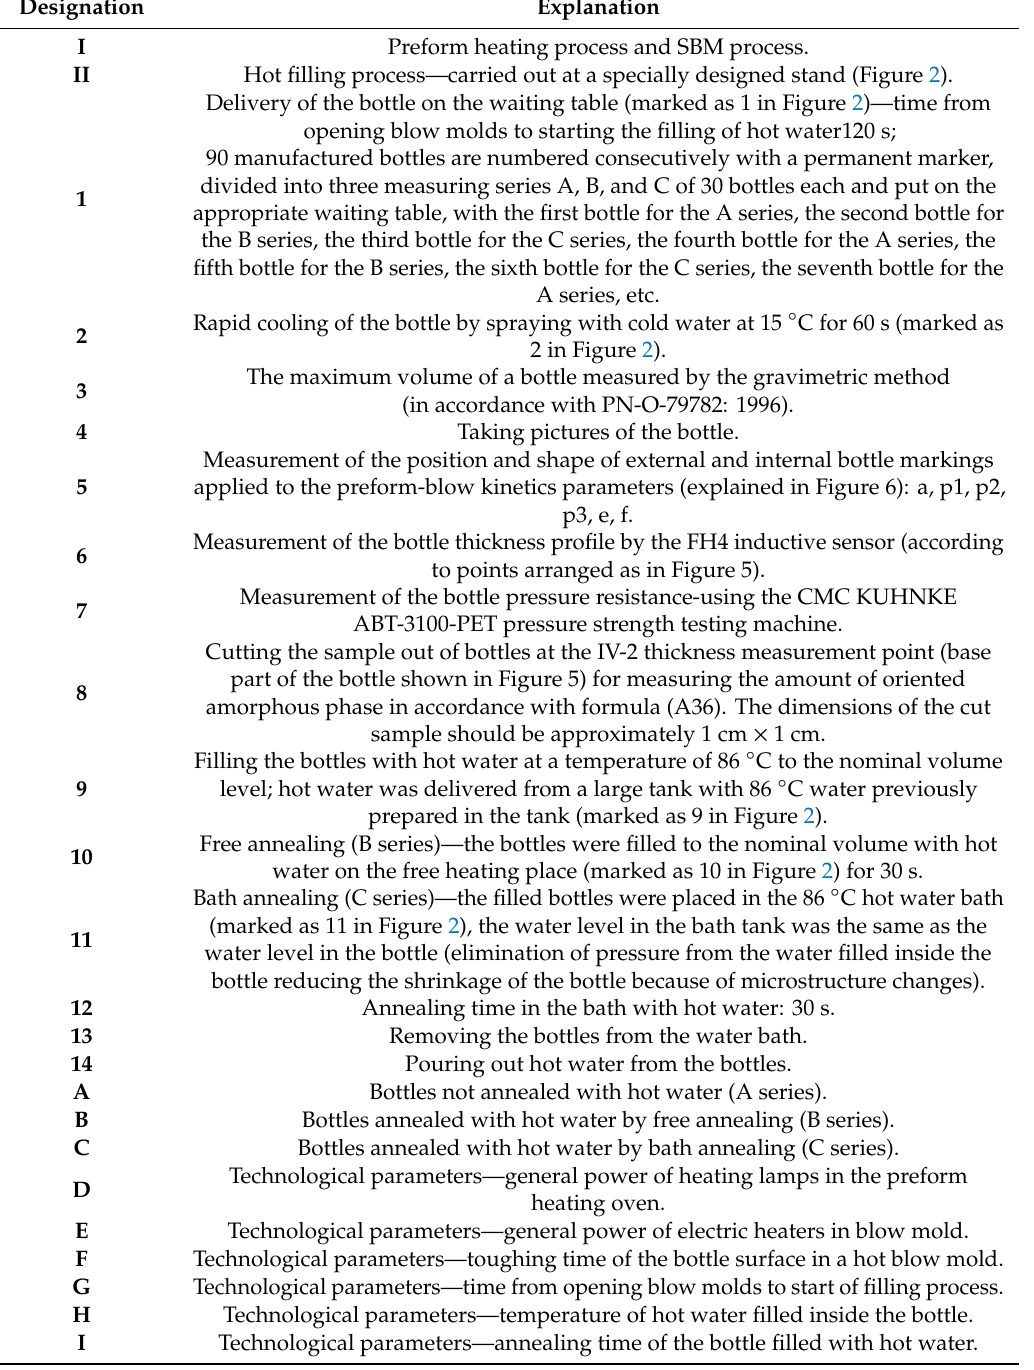
Table 1. Explanation of designations used in Figure